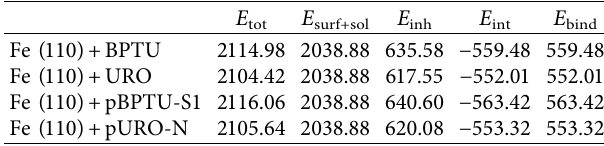
Figure 17: Configurations of (a) BPTU, (b) pBPTU-S1, (c) URO, and (d) pURO-N on Fe (110) surface in acidic solution. Table 7: Energy values (kcal.mol − 1 ) of inhibitor molecule ad- sorption on the Fe (110) surface in acidic